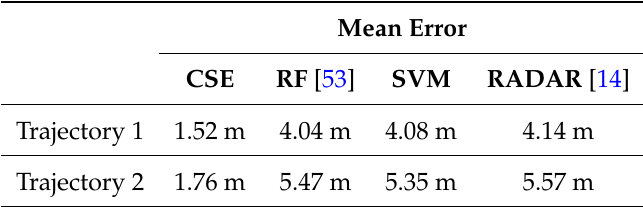
Table 2. Experimental results: test using the trajectory datasets.